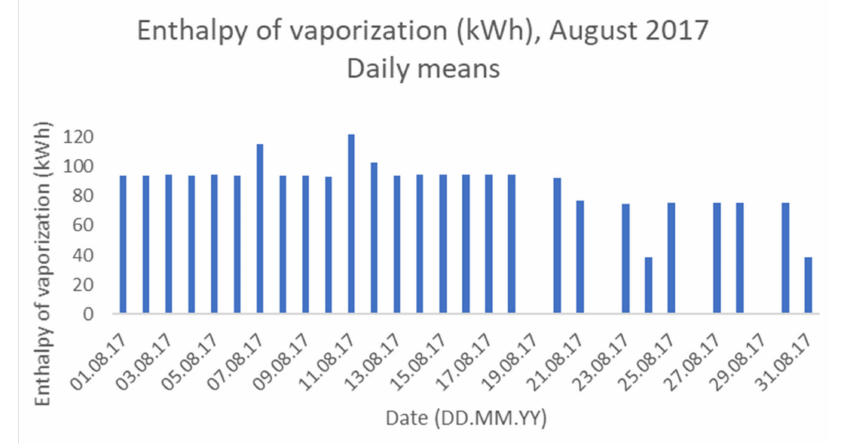
Figure 7. Daily mean values of evaporation energy (kWh) in August 2017.